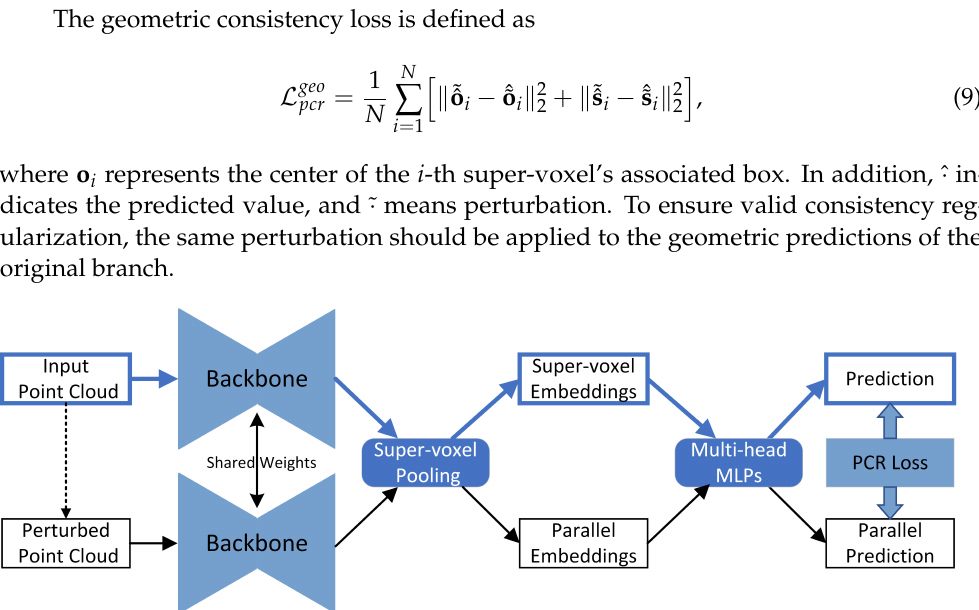
Figure 3. Illustration of the perturbation-based consistency regularization (PCR) module. We construct a parallel branch through data perturbation and force the output predictions of the two branches to be consistent. Note that the predictions include both semantics and